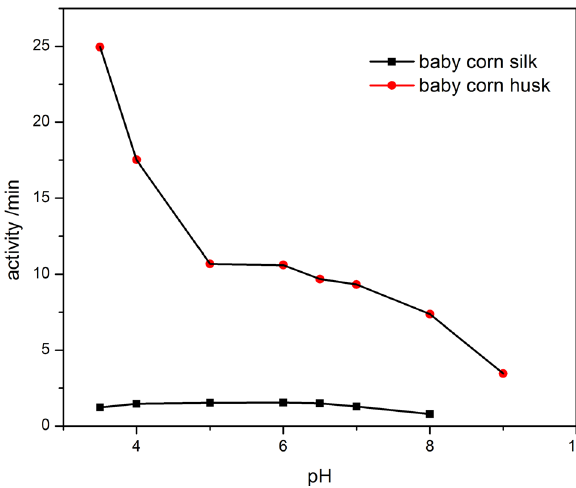
Fig. 6 Optimization of pH for bay corn silk and husk